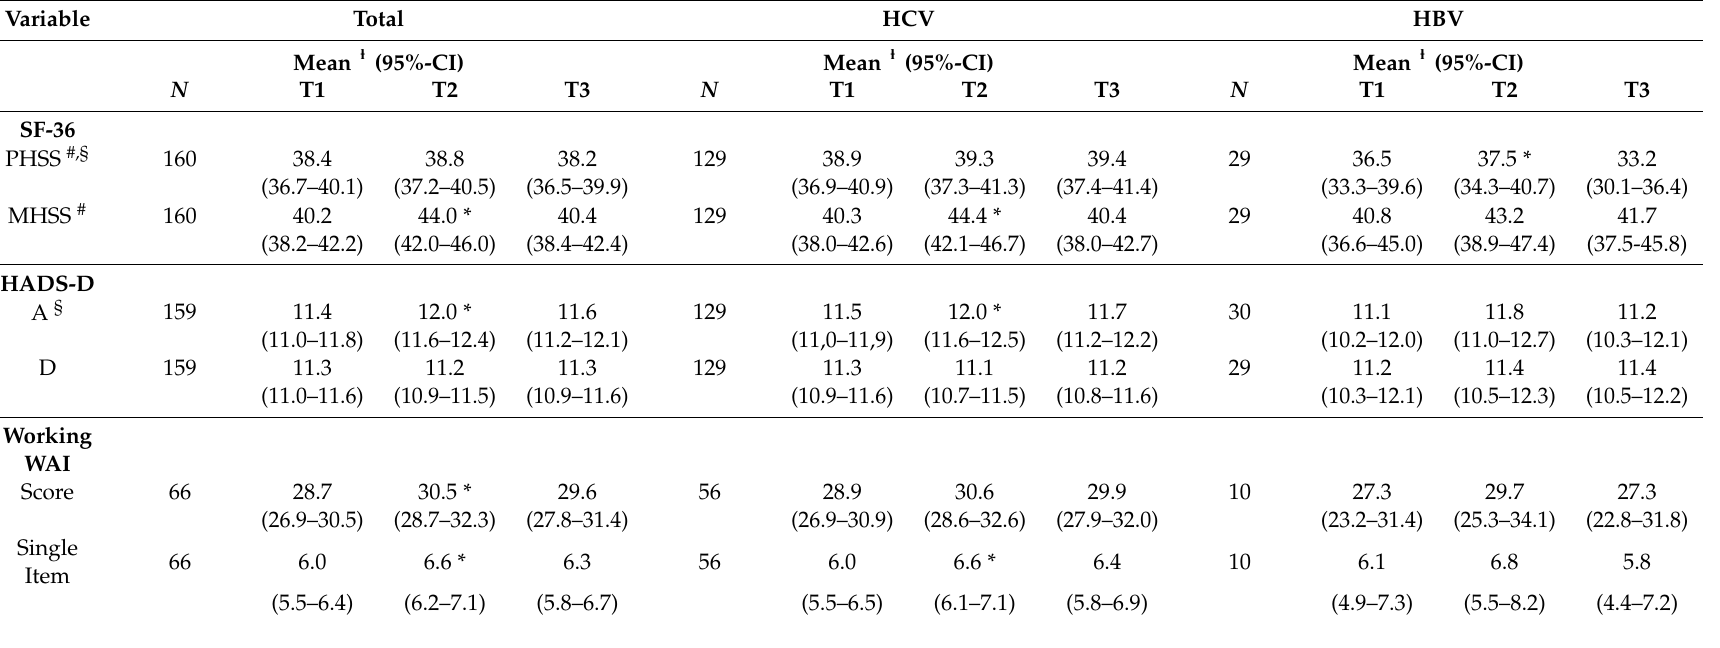
Table 3. Survey results—mean values from the overall cohort and stratified by type of hepatitis. Variable